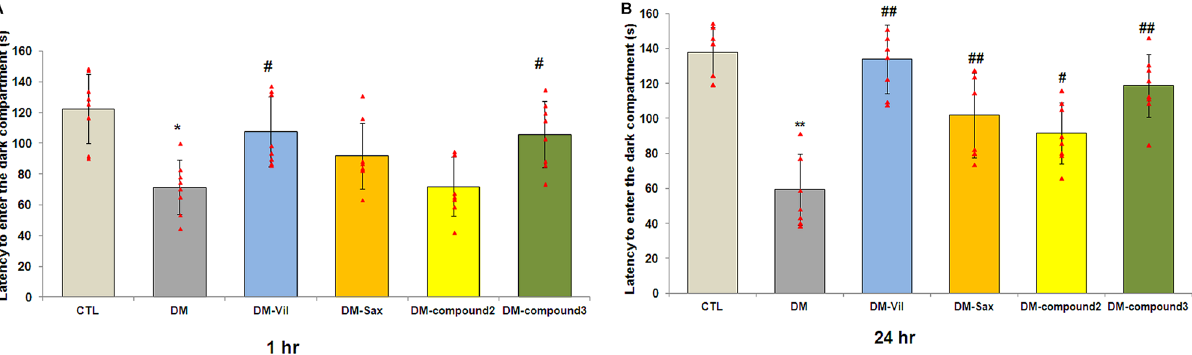
Figure 5. Treatment with novel adamantane derivatives ( 2 , 3 ) or drugs—vildagliptin and saxagliptin, attenuates memory impairment in induced diabetic mice in passive avoidance test (PA). Retention test was performed after 1 h ( A ) and 24 h ( B ) after the end of the training stage. The bars illustrate the latency to enter the dark compartment of apparatus in testing stage for experimental groups— CTL non-diabetic mice, DM diabetic mice, DM‑Vil vildagliptin-treated mice [20 mg/kg, po ], DM‑Sax saxagliptin-treated mice [10 mg/kg, po ], DM‑compound 2 compound 2-treated mice [50 mg/kg, po ], DM‑compound 3 compound 3-treated mice [50 mg/ kg, po ], respectively. Each column represent means ± SD (n = 8). Repeated-measures ANOVA, followed by Tukey’s post hoc test was used. (A-B) *p < 0.05 ; **p < 0.01 compared with healthy control group. ( A , B ) # p < 0.05; ## p < 0.01 compared with diabetic mice